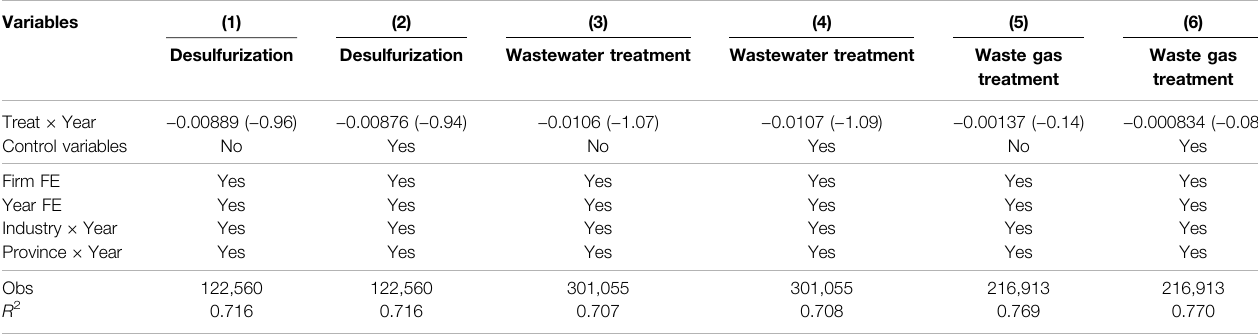
TABLE 13 | Results of the mechanism of end-pipe treatment. Variables